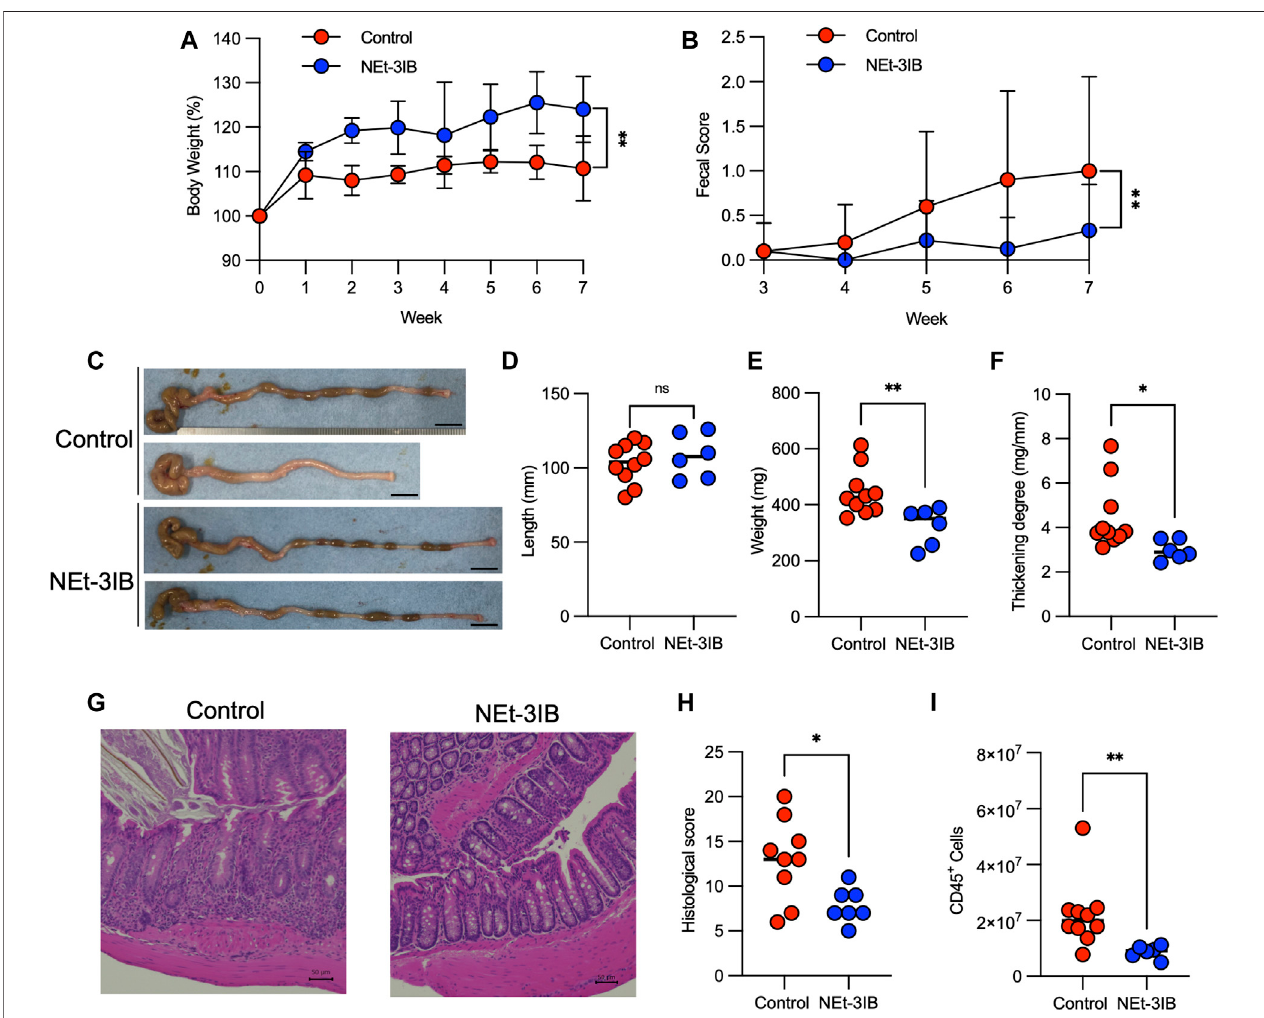
FIGURE2| NEt-3IBamelioratesT-cell-dependentexperimentalcolitis. (A – H) ExperimentalcolitiswasinducedbyadoptivetransferofCD4 + CD45RB high Tcellsinto C.B-17 scid/scid mice fed with control or NEt-3IB-containing diet for 7 weeks, and bodyweight loss (A) and diarrhea score (B) were observed. Data shown are the average. Area under the curve of bodyweight change and fecal score. (C – F) Colon length, colon weight, and colon thickening were observed and measured in week 7. Scale bar: 1 cm. (G) Colonic specimens were stained with hematoxylin and eosin (HE). (H) Histological scores of colonic specimens. (I) Total CD45 + cells in the colon lamina propria of the CD4 + CD45RB high T cell transfer model. * p < 0.05, ** p < 0.01.